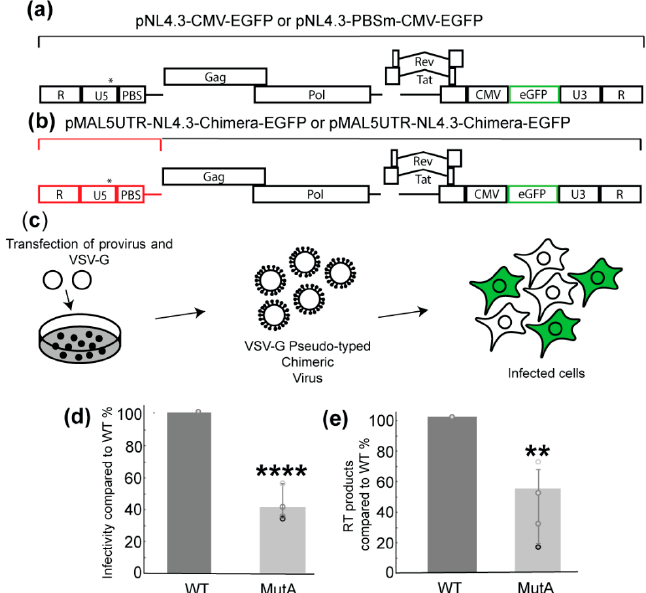
Figure 2. Cell-based infectivity and reverse transcription product assays to compare the replication efficiency of the WT and Mut-A viruses. ( a ) Map of the pro-viral plasmid used for the pseudo-typed virus production and cell-based assays. An asterisk indicates the approximate location of A-rich loop mutations. ( b ) A chimeric molecular clone was created using the MAL 5 ′ UTR and NL4.3 backbone. The MAL 5 ′ UTR is highlighted in red. An asterisk indicates the approximate location of A-rich loop mutations. ( c ) Schematic of a single-cycle infectivity assay. Pro-viral and vesicular stomatitis virus (VSV-G) plasmids were transfected in 293FT cells. VSV-G pseudo-typed chimeric viruses were harvested and used to infect TZM-bl cells. Flow cytometry was used to measure the percentage of EGFP-expressing cells. ( d ) Mutation of the A-rich loop lowered the infectivity of the pseudo-typed virus. ( e ) Mutation of the A-rich loop led to reduced reverse transcription products in cells infected by the pseudo-typed virus. The cDNA products were quantified by qPCR. Graphs are representative of four experiments, average ± standard deviation; ** p < 0.01 and **** p < 0.0001.